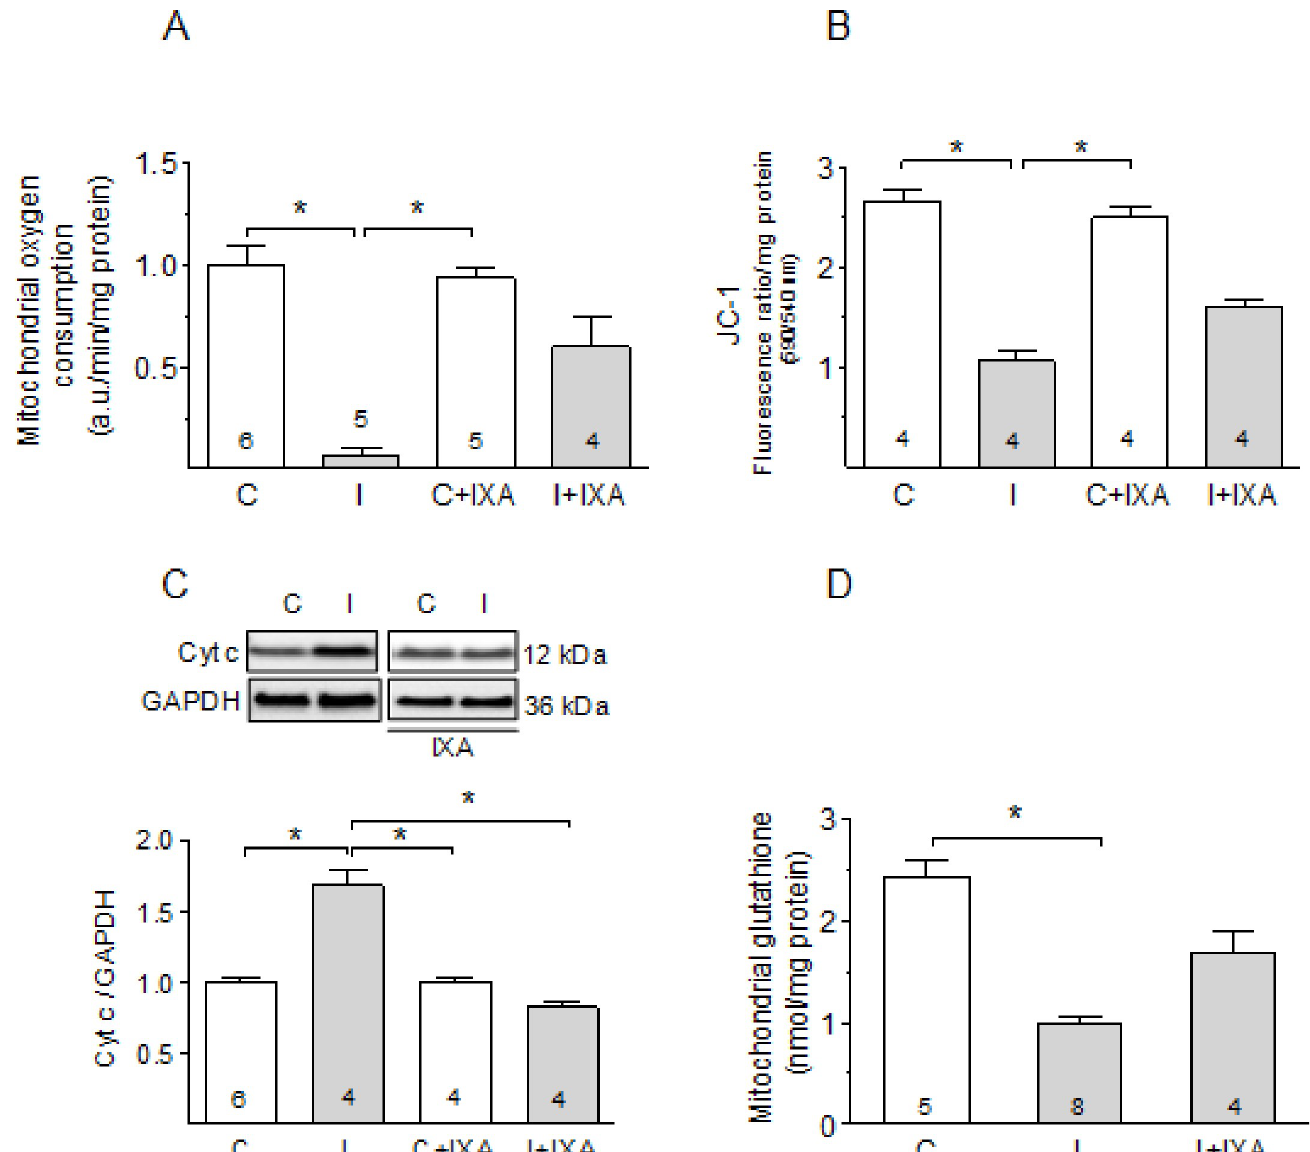
Fig 2. Mitochondrial function after ischemia is preserved by ixazomib. (A) Oxygen consumption, (B) JC-1 fluorescence ratio 590/540, (C) cytosolic cyt c and (D) mitochondrial glutathione content in mitochondria isolated from control hearts or after 30 minutes of ischemia with or without previous perfusion with IXA. Labels C: control, I: ischemia. Oxygen consumption and Cyt c were expressed relative to controls. Number of measurements in different hearts is shown in each bar. � p < 0.05. Kruskal-Wallis test followed by Dunn‘s test.